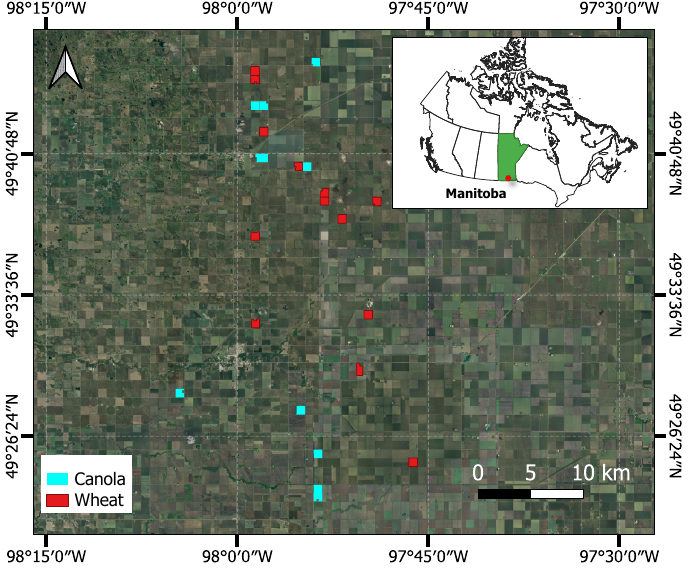
Figure 1. Map of the study area showing the locations of the canola and wheat fields over the Manitoba province of